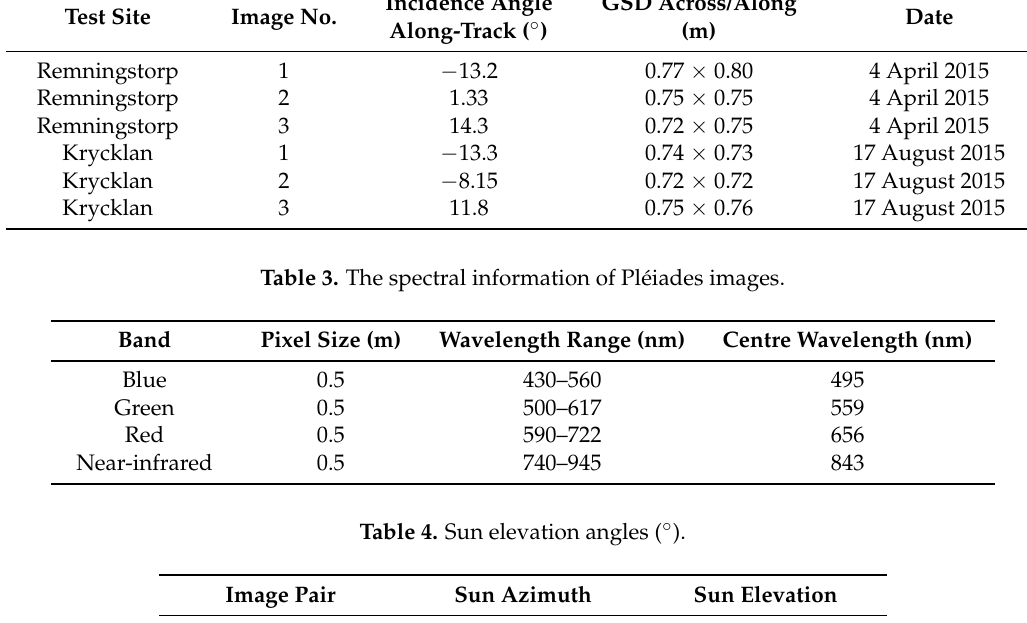
Table 2. Acquisition properties for the satellite images. Ground sampling distance (GSD).